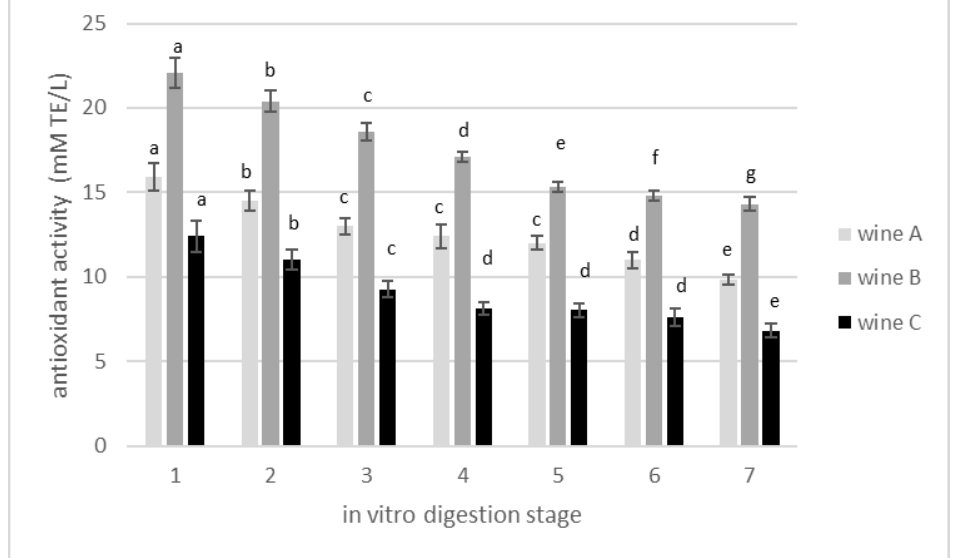
Figure 4. Changes in antioxidant activity expressed as mM Trolox equivalent (mM TE/L) in cherry wines during in vitro digestion. 1 — wine before digestion; 2 — after stomach; 3 — small intestine,